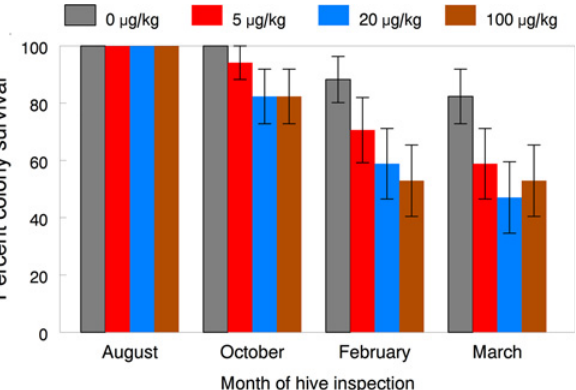
Fig 9. Proportion of colonies exposed for 12 weeks to untreated or imidacloprid-spiked diet patties and survived to August (end of exposure), October, February and March (successful overwintering). Means ( ± SE) pooled over both years are given for each exposure group and inspection month. Logistic regression results for the overall dose effect ( F (3, 15) = 4.21, p = 0.024; significant of differences between control colonies and colonies exposed to 5 μ g/kg ( p = 0.201), colonies exposed to 20 μ g/kg ( p = 0.027), and colonies exposed to 100 μ g/kg ( p =